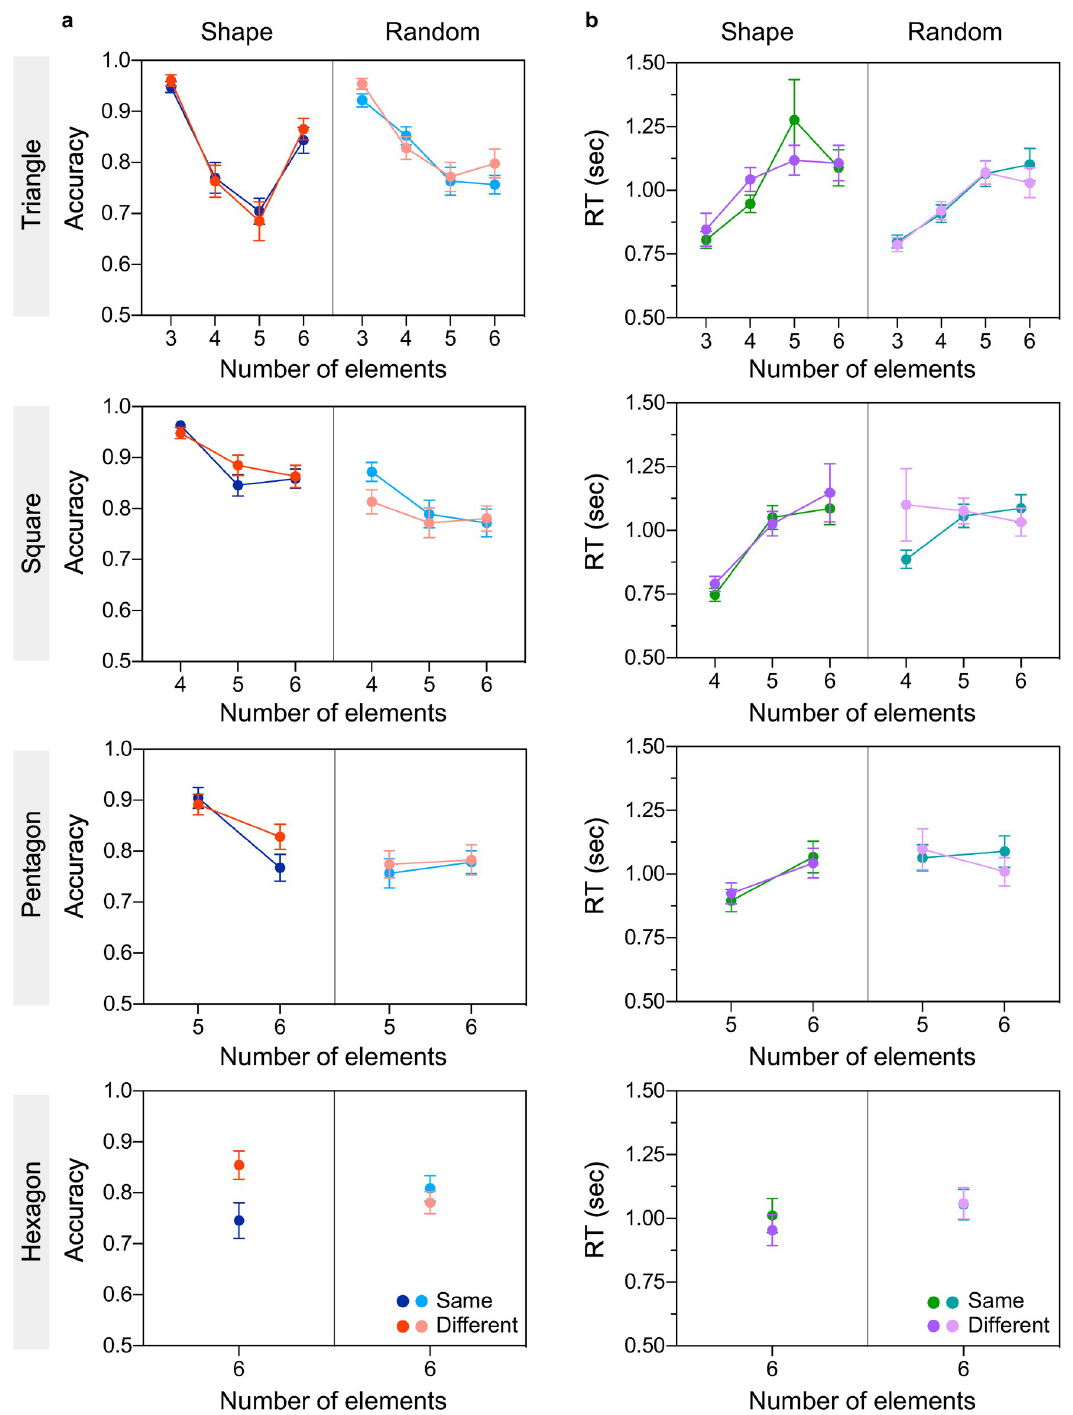
Fig 3. Experiment 1 results (effect of colour). (a) Accuracy and (b) reaction time are plotted as a function of number of elements for simple shape (left side of each panel) and random (right side of each panel) configurations, and for same (blue/green symbols) and different (red/purple symbols) colour conditions. Top to bottom panels correspond to different simple shape configurations: Equilateral triangle (top panel), square, pentagons and hexagon (bottom panel) configuration. The error bars indicate standard error of the mean ( ± 1